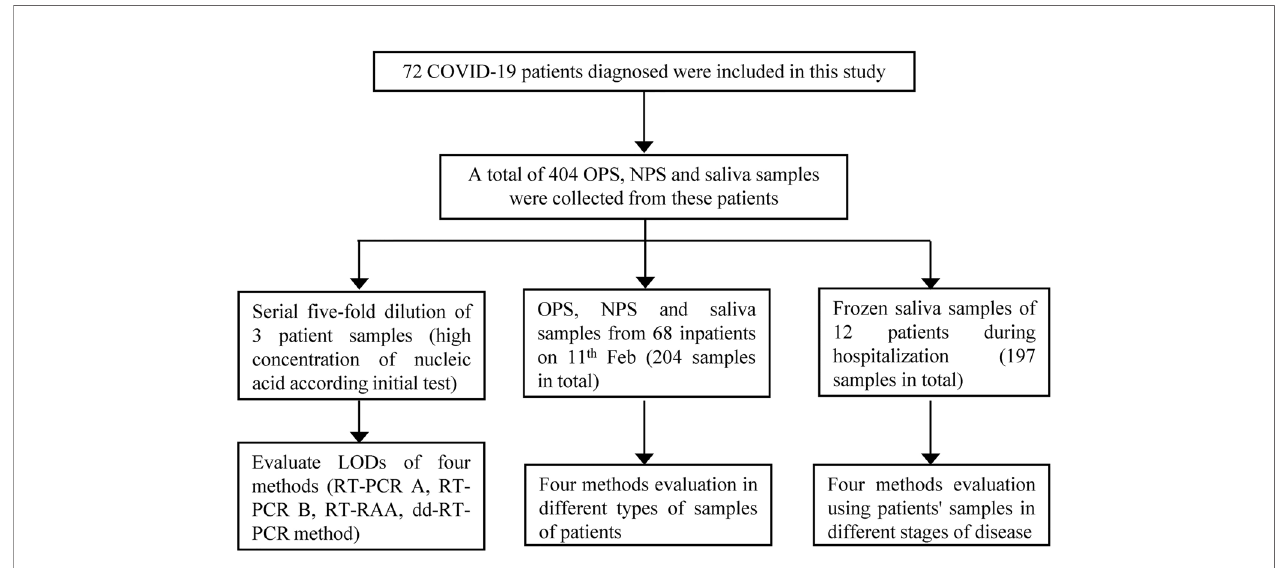
FIGURE 1 | Flowchart of patient/sample recruitment and study fl ow.